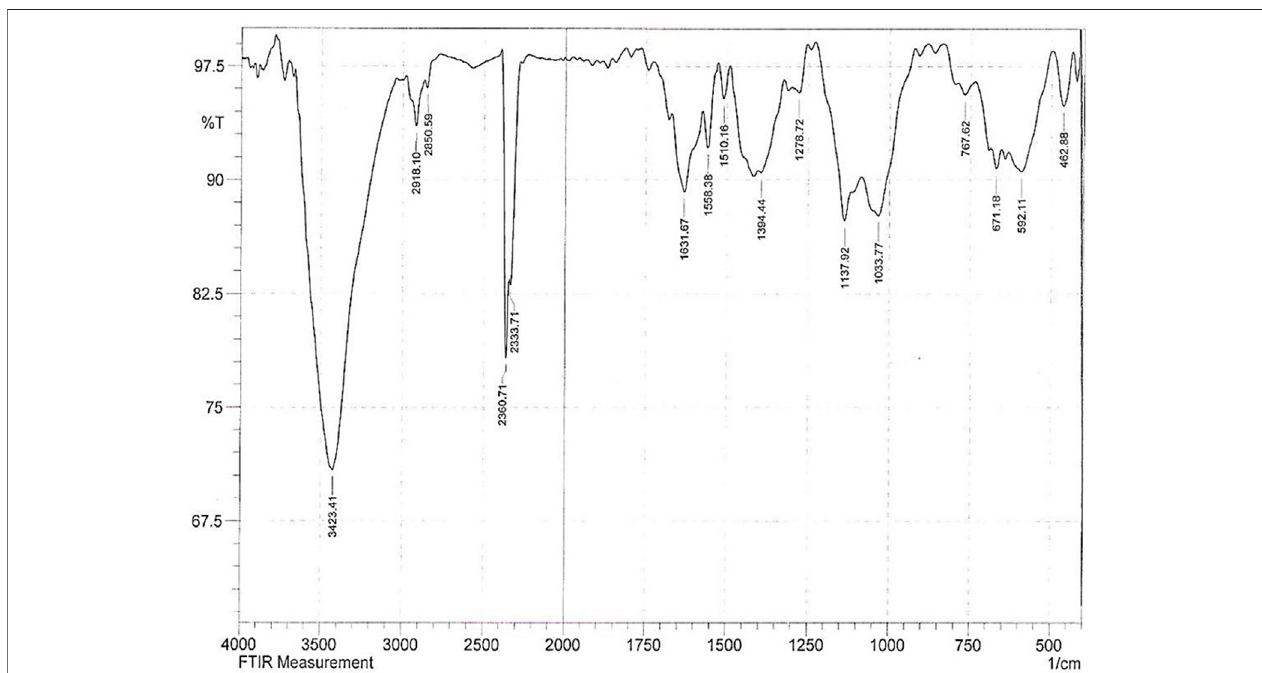
FIGURE 4 | FE-SEM image of synthesized Fe 3 O 4 @SiO 2 @Tannic acid MNPs.